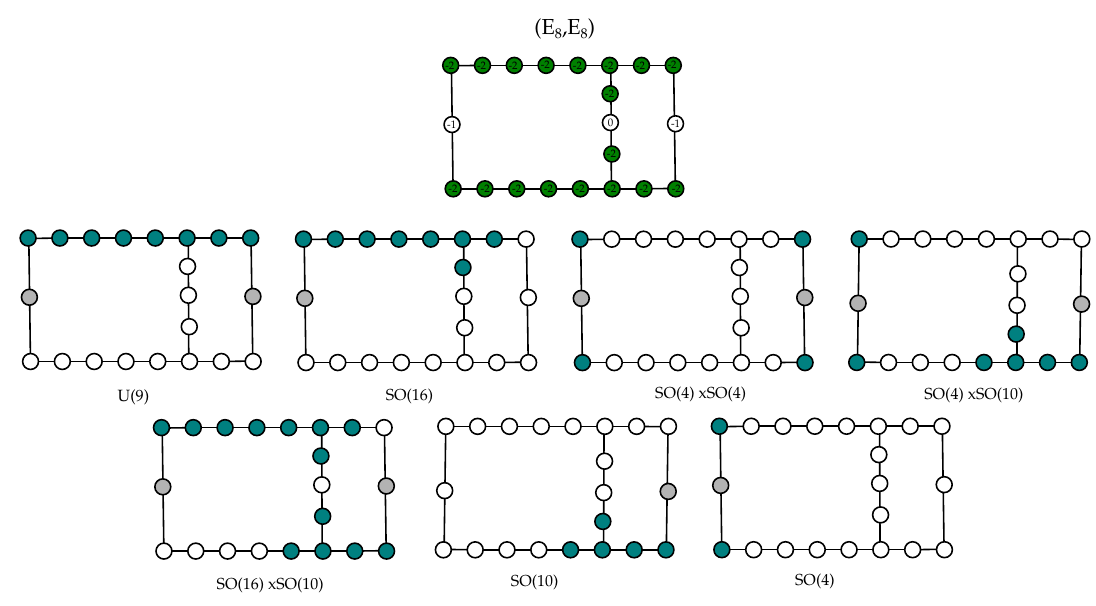
Figure 17. Embedding of potential BG-CFDs into the ( E 8 ; E 8 ) Marginal